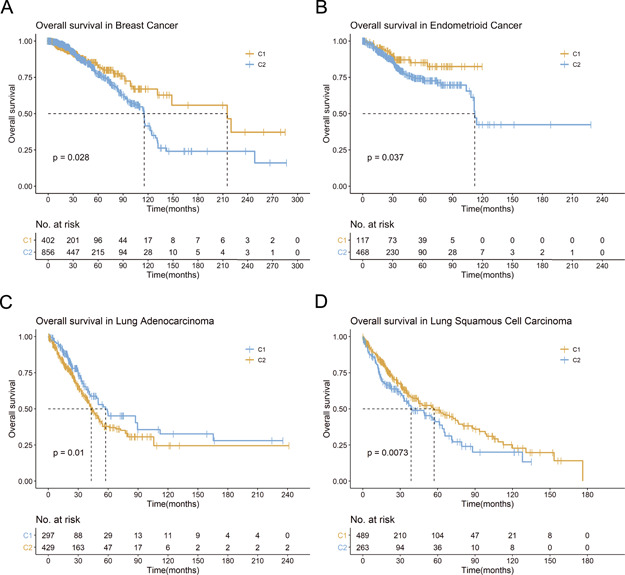
Example for ATdb application. Kaplan–Meier plot for (A) breast cancer (TCGA-BRCA); (B) endometrioid cancer (TCGA-UCEC); (C) lung adenocarcinoma (TCGA-LUAD); (D) lung squamous cell carcinoma (TCGA-LUSC).